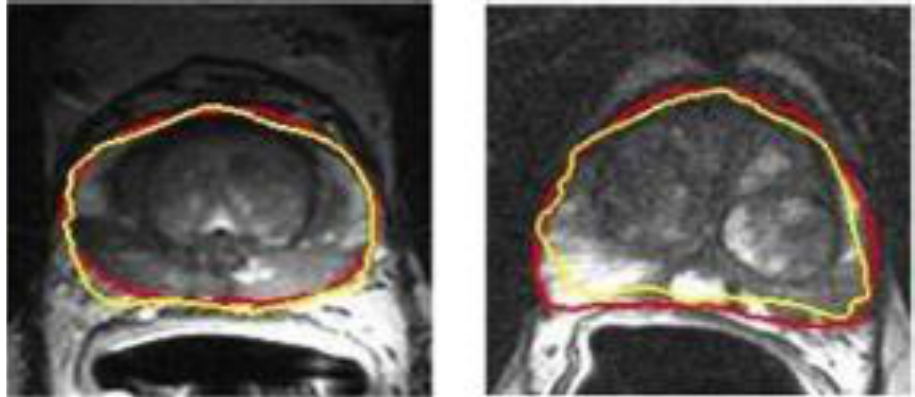
Figure 18. Segmentation results of glands and their boundaries. Red: ground truth; yellow: segmen- tation contour by the proposed algorithm. Adapted with permission from ref. [138]. Copyright 2018 Elsevier.